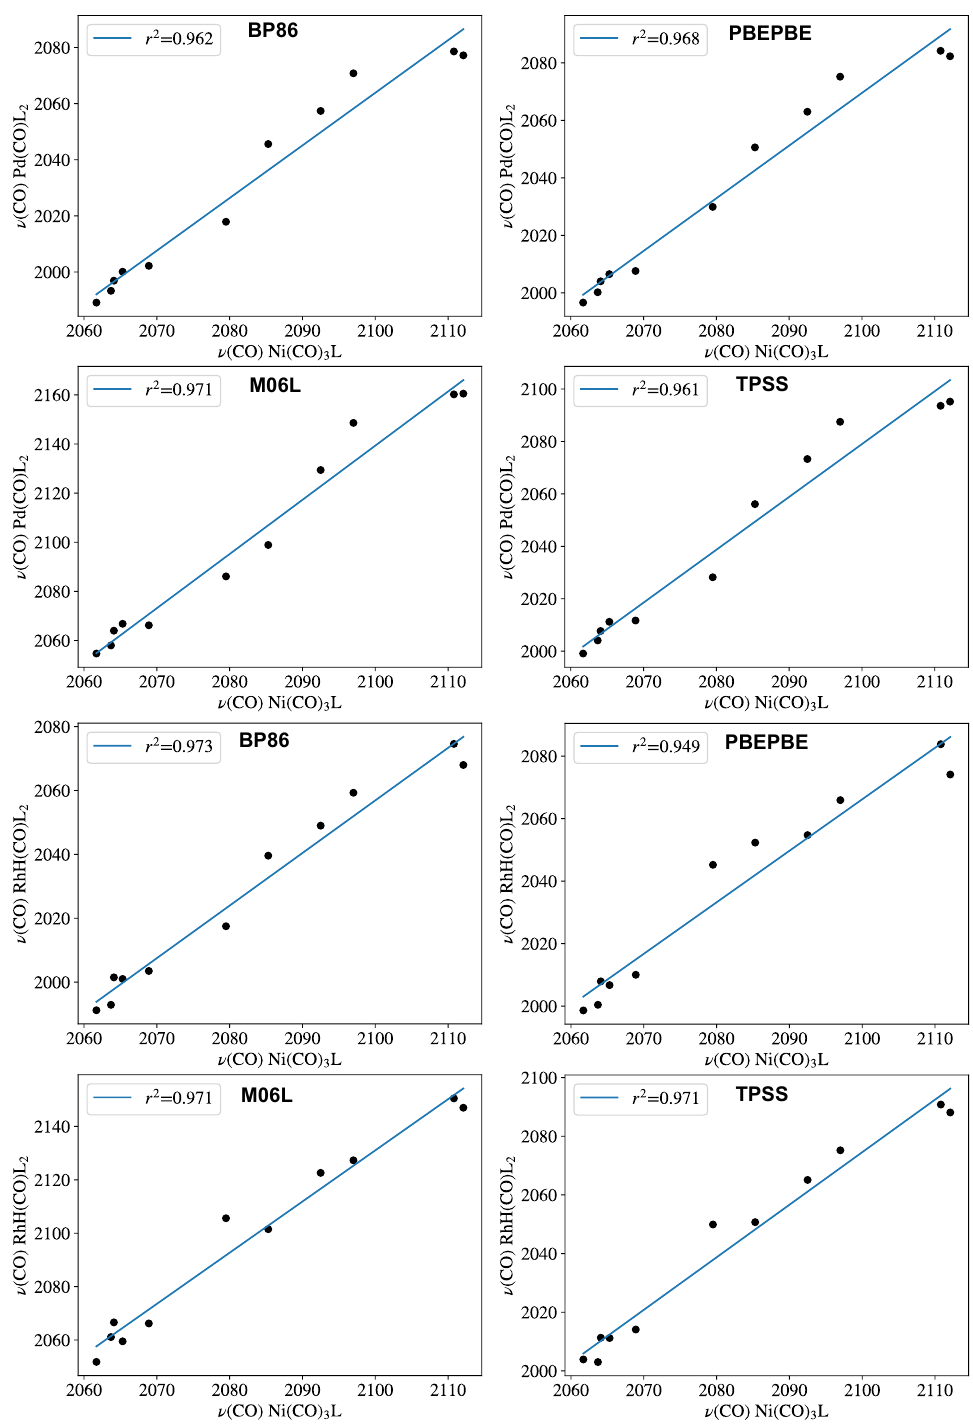
Figure 3. Carbonyl-stretching frequencies of PdL 2 (CO) (top row) and HRhL 2 (CO) against Tolman’s parameter computed with various DFT functionals. Frequency values are given in Table